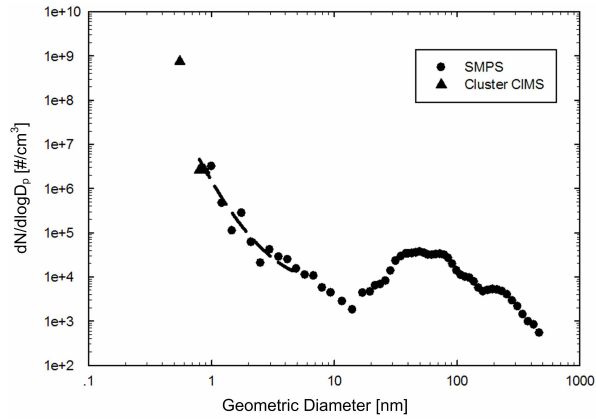
Fig. A4. Particle size distribution observed on 13:00, 7 August 2009 (NCCN). Filled triangles are data obtained by the cluster chemi- cal ionization mass spectrometer (Cluster CIMS) and filled circles are data obtained from two scanning mobility particle spectrome- ters (SMPS) (Jiang et al., 2011b). The dashed line is obtained by fitting a second order polynomial using the method of least squares to the data over the size range where growth rates are calculated in this